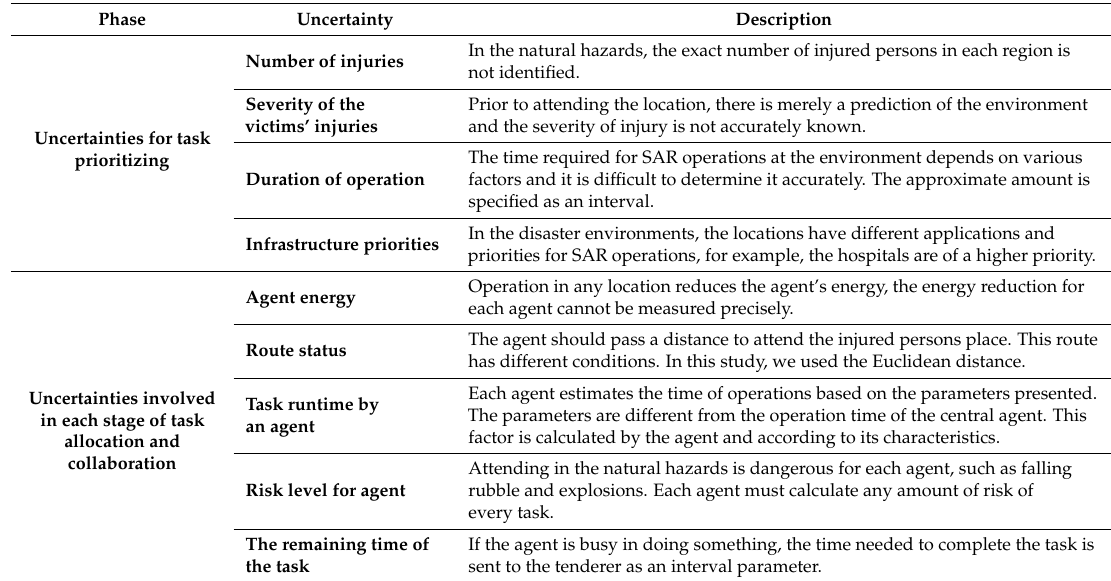
Table 3. The reflected uncertainties for task prioritizing and uncertainties involved in each stage of task allocation and collaboration between